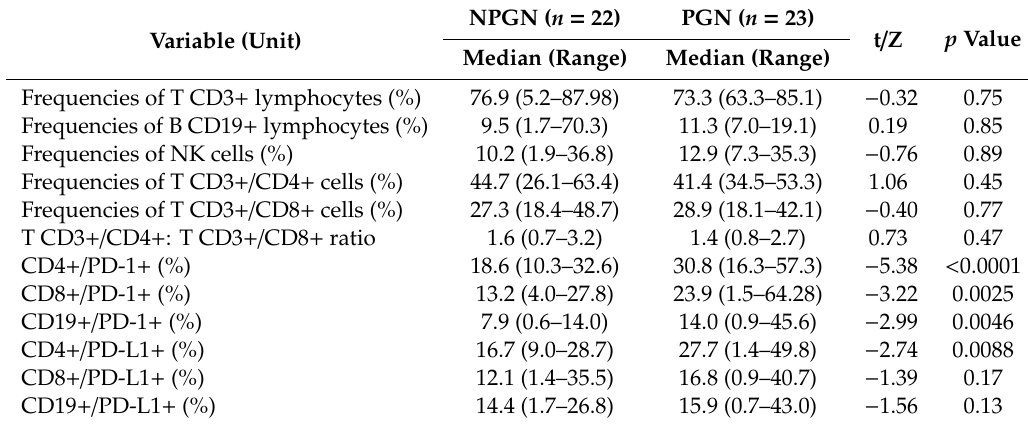
Table 4. Results of the immunophenotyping of the peripheral blood lymphocytes of the NPGN and PGN patients. Cells were enumerated and presented as % of a specific subpopulation within the leukocyte (CD45 + )